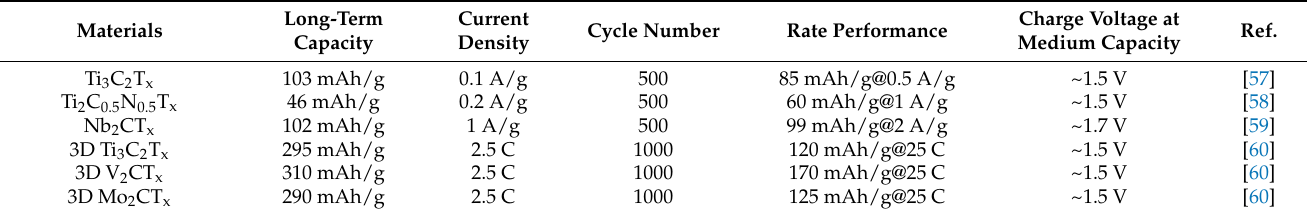
Table 1. Performance comparison of different MXene anodes in